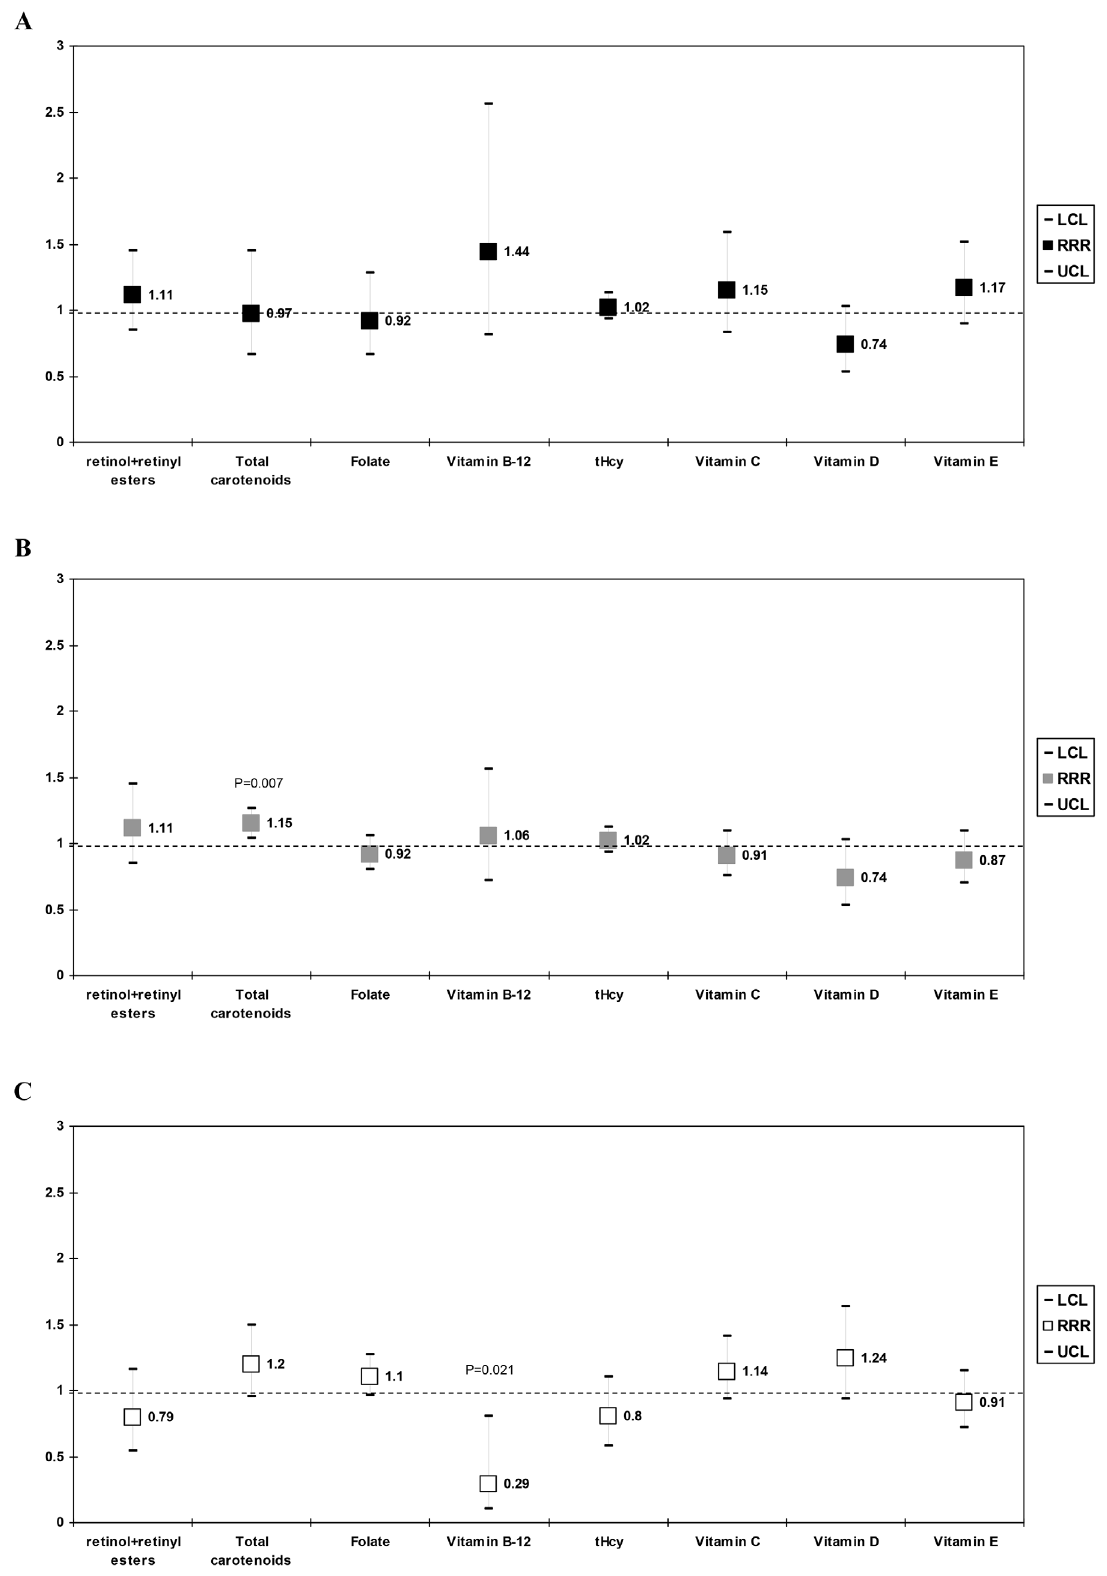
Figure 2. Relative risk ratio (RRR with 95% CI) per 1 SD nutritional biomarker: (A) Very short sleep vs. Normal sleep duration a,b , (B) Short sleep vs. Normal sleep duration a,b , (C) Long sleep vs. Normal sleep duration a,b . Abbreviations : BMI=Body Mass Index; CI=confidence interval; Met=Metabolic Equivalent; n-3 HUFA=omega-3 highly unsaturated fatty acids; NHANES=National Health and Nutrition Examination Survey; RRR=relative risk ratio; SEE=Standard error of the estimate. a Values are Relative Risk Ratios (RRR) with 95% confidence intervals.